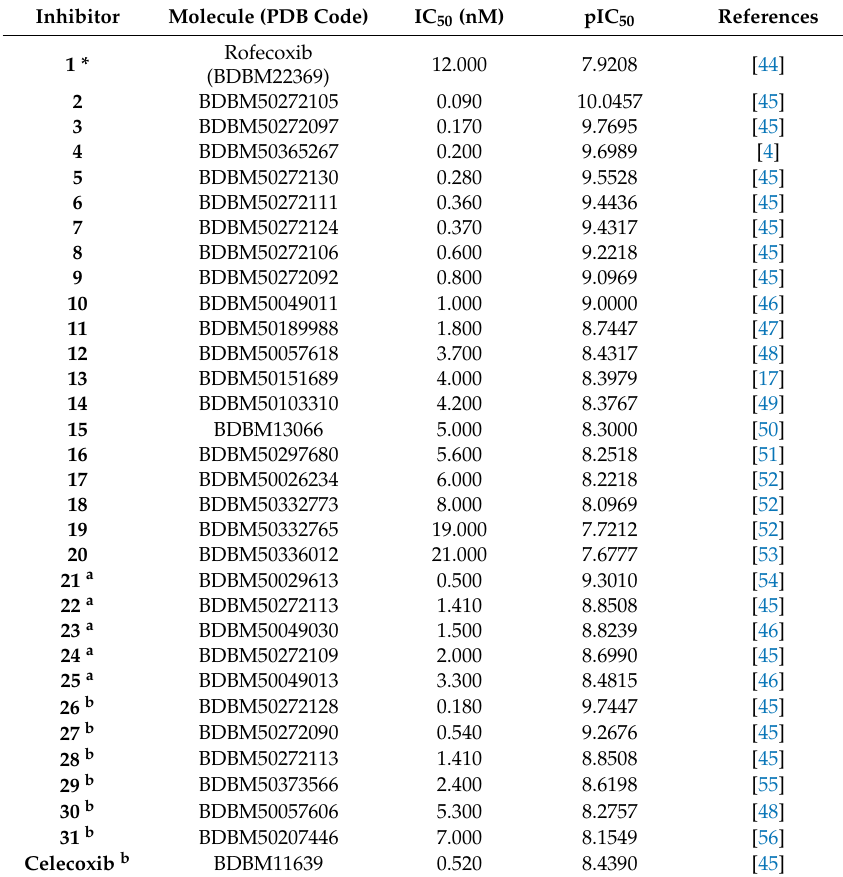
Table 15. Molecules selected in ascending order of IC 50